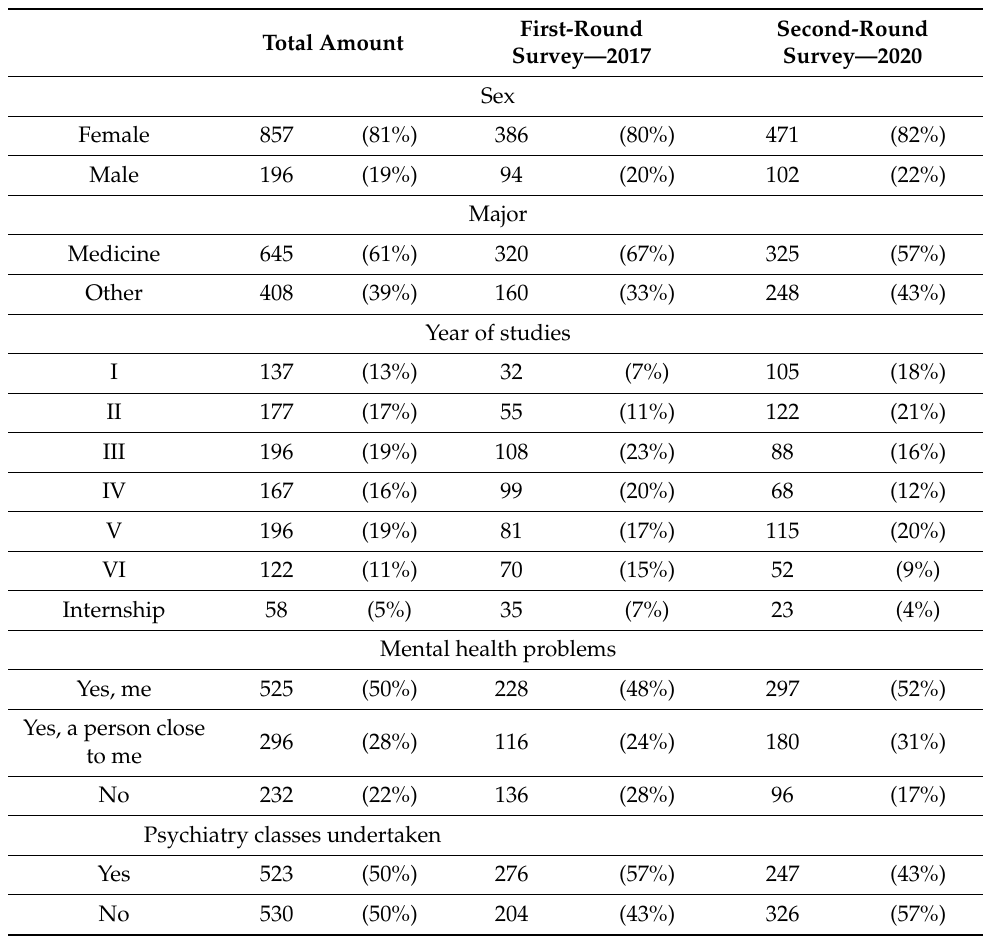
Table 1. Characteristics of the study